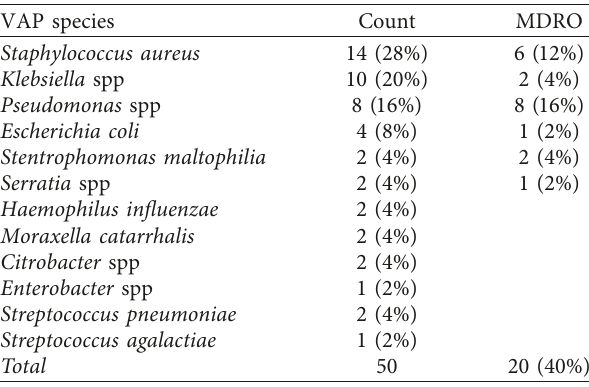
Table 3: Frequency of VAP organisms and